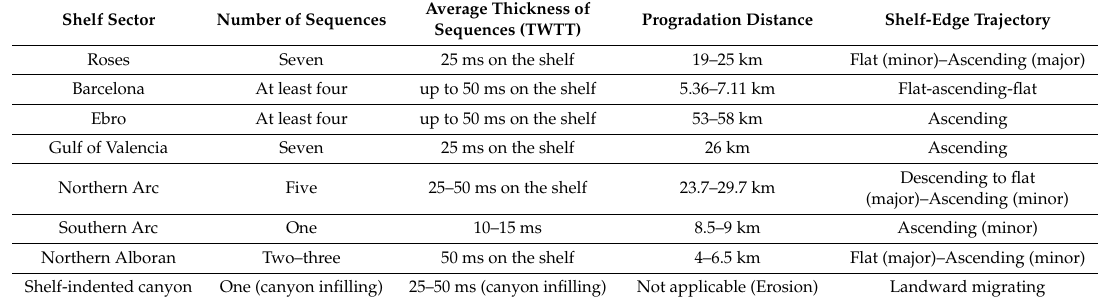
Table 2. Quantification of main stratigraphic parameters deduced from the representative seismic sections and corresponding interpretations.